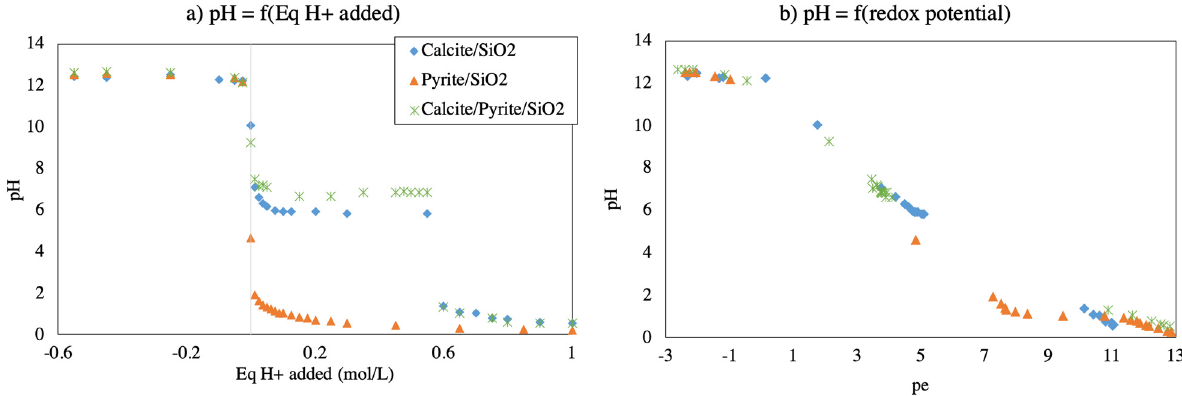
Figure 1. pH ( a ) and redox potential ( b ) of three synthetic matrices: calcite/SiO 2 , pyrite/SiO 2 , and calcite/pyrite/SiO 2 . The vertical line indicates the point of equilibrium with pure water (in Figure 1a).